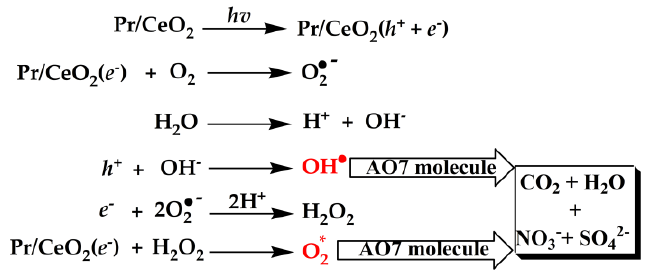
Figure 10. Proposed radical−ions mechanism for AO7 degradation.